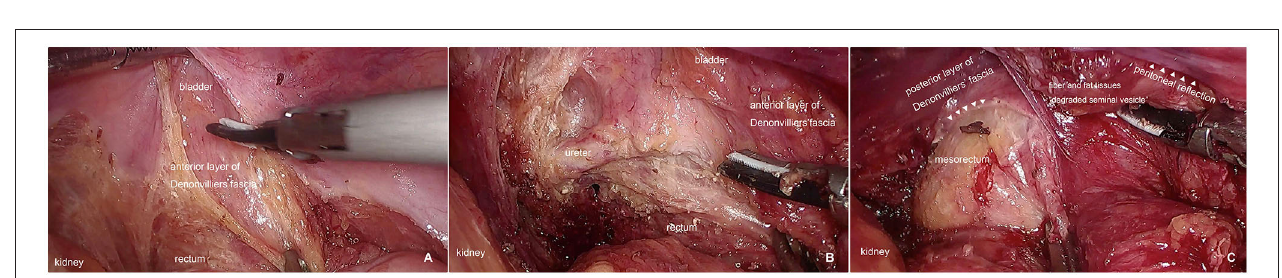
FIGURE 2 | (A–D) Intraoperative images of abdominal dissection under laparoscopy.